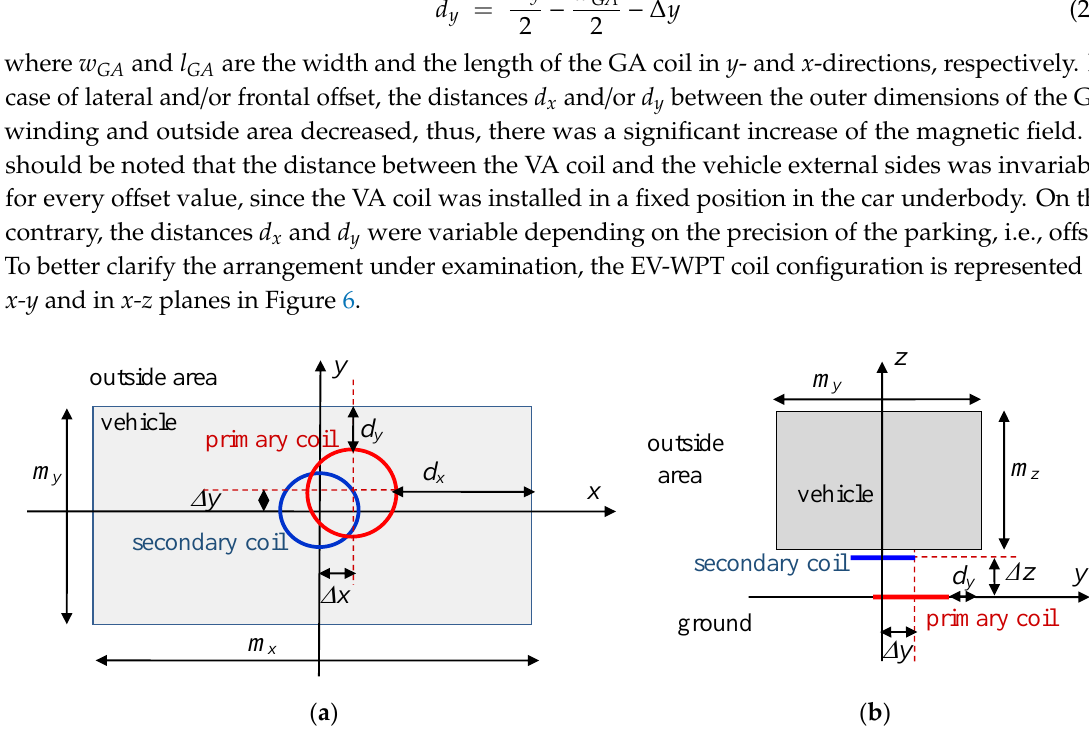
Figure 6. Sketch of the electric vehicle- (EV) WPT coil configuration in x-y plane (top view) ( a ) and in y-z plane (front view) ( b ).